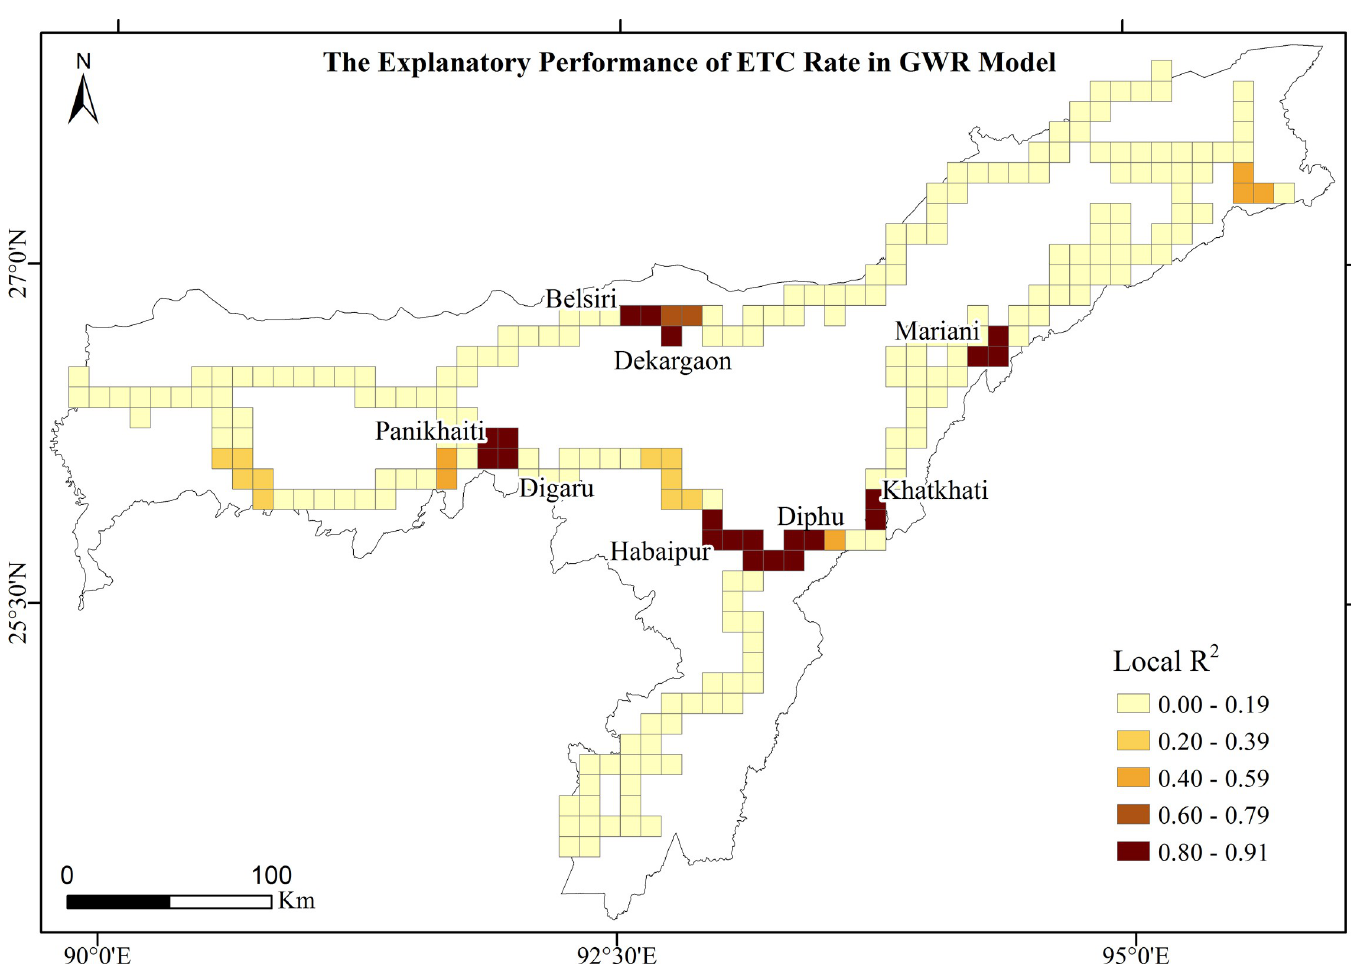
Fig 8. GWR model showing explanatory performances of ETC rates in the prioritized